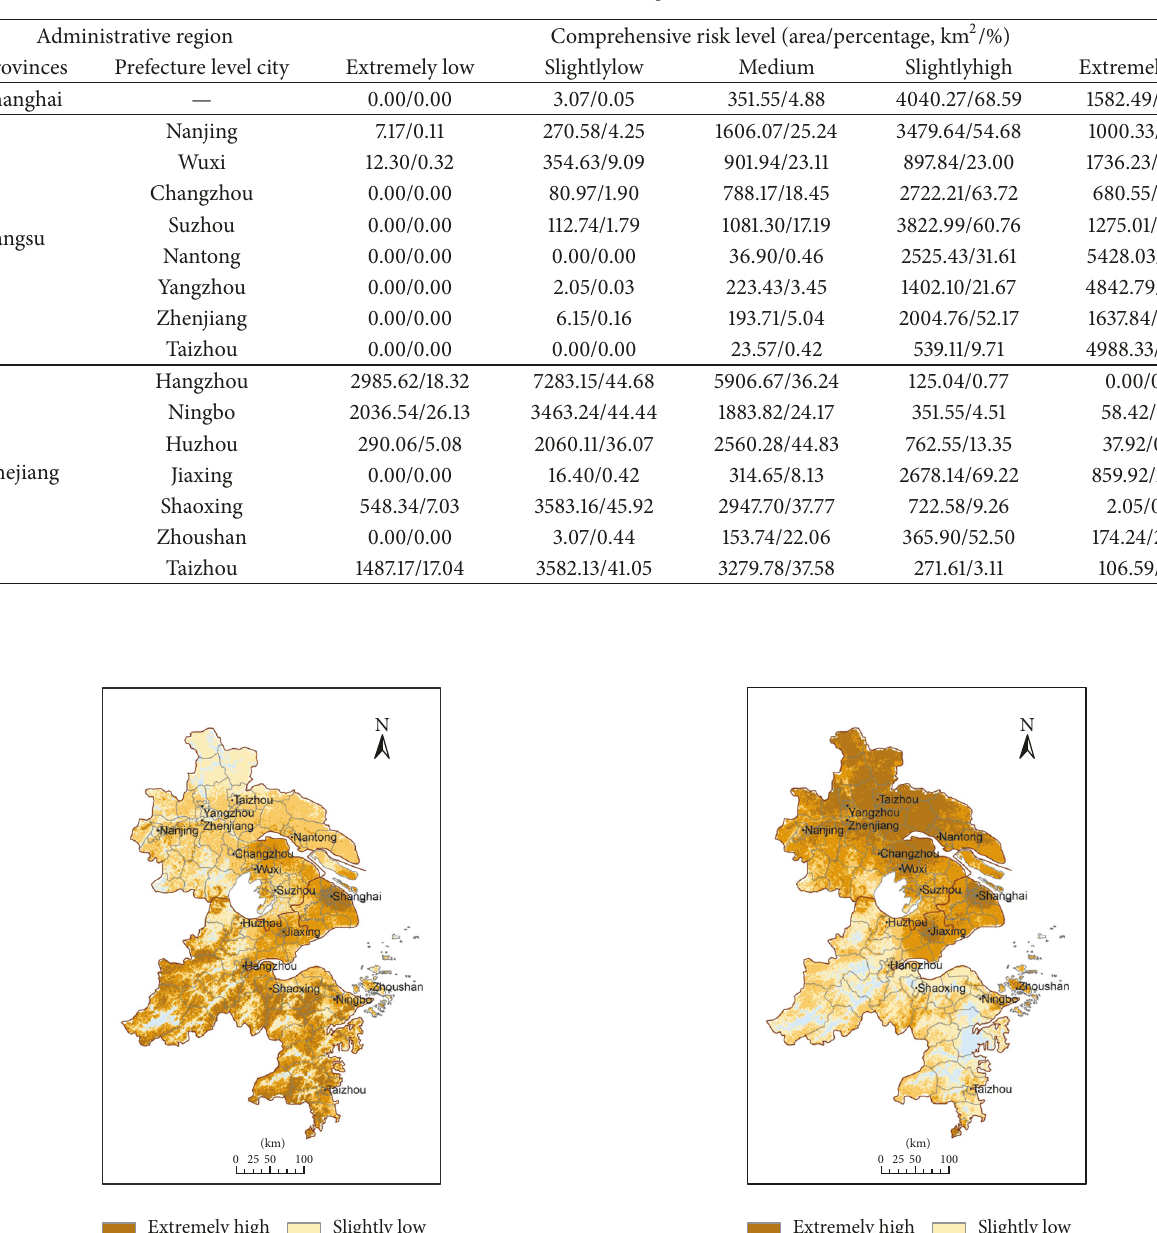
Table 5: Statistics of risk levels of drought disasters in the YRDR.